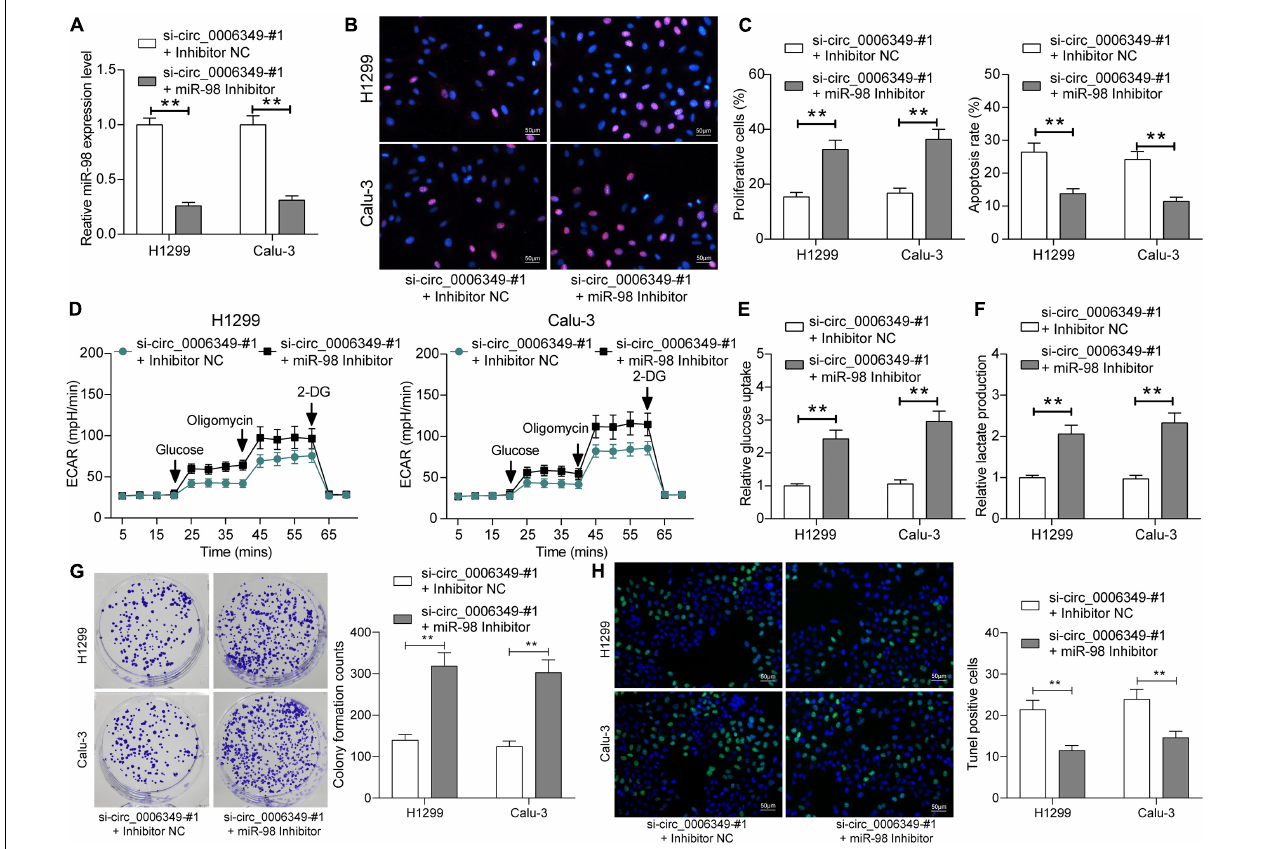
FIGURE 5 | miR-98 inhibitor promotes the malignant behaviors of NSCLC cells. (A) Transfection efficacy of miR-98 in H1299 and Calu-3 cells determined by RT-qPCR; (B) DNA replication activity of H1299 and Calu-3 cells measured by EdU labeling assay; (C) apoptosis of H1299 and Calu-3 cells detected by the flow cytometry; (D) ECAR in H1299 and Calu-3 cells; (E,F) glucose uptake (E) and lactate production (F) in H1299 and Calu-3 cells; (G) colony formation ability of H1299 and Calu-3 cells examined by the colony formation assay; (H) apoptotic bodies in H1299 and Calu-3 cells examined by the TUNEL assay. Differences were compared by two-way ANOVA (A–C,E–H) . All data were presented as the mean ± SD from three independent experiments. ** p <